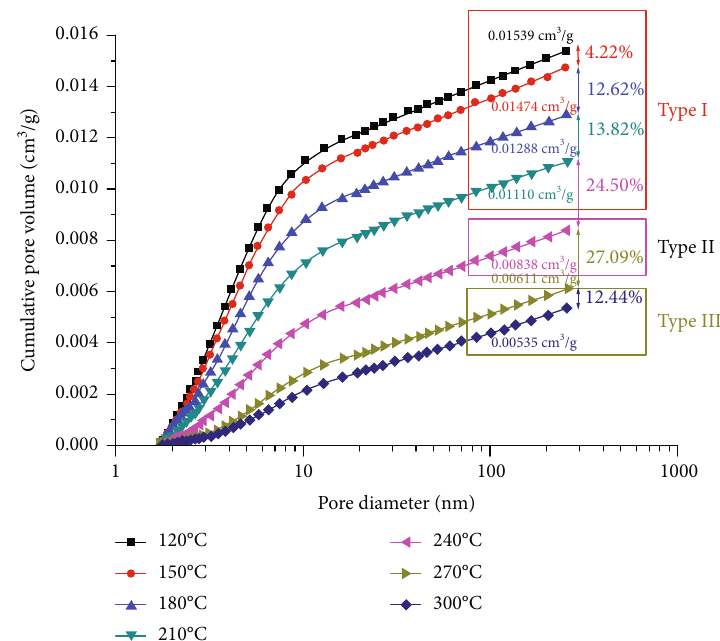
Figure 4: The cumulative PV under various pretreatment